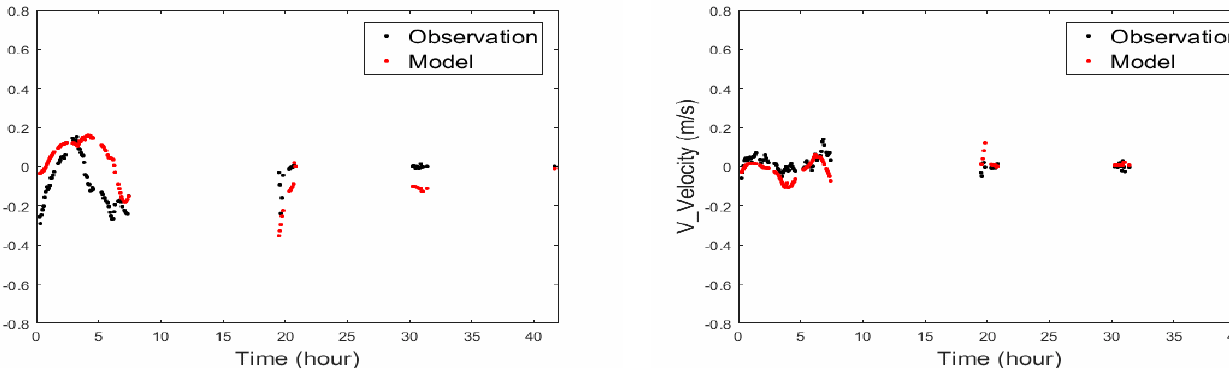
Figure 10. Time series velocities comparison between observed SCT2 drifter data and FVCOM data. U-velocity is on the left , and V-velocity is on the right .